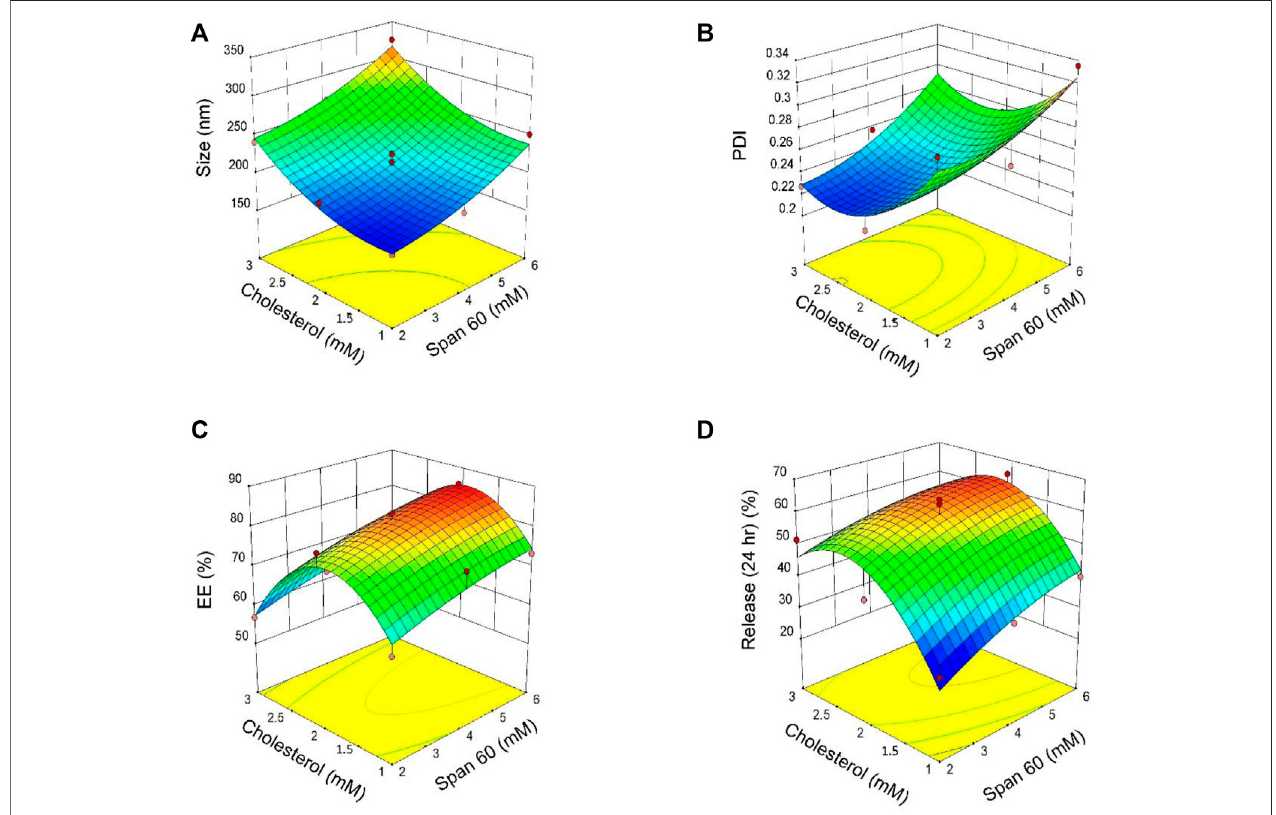
FIGURE2| 3Dplotsoftheresultsderivedfromthecentralcompositedesignforsize (A) ,polydispersityindex[PDI; (B) ],encapsulationef fi cacy[EE; (C) ]andrelease (D) as a function of the parameters (concentrations of Span ® 60 and cholesterol).